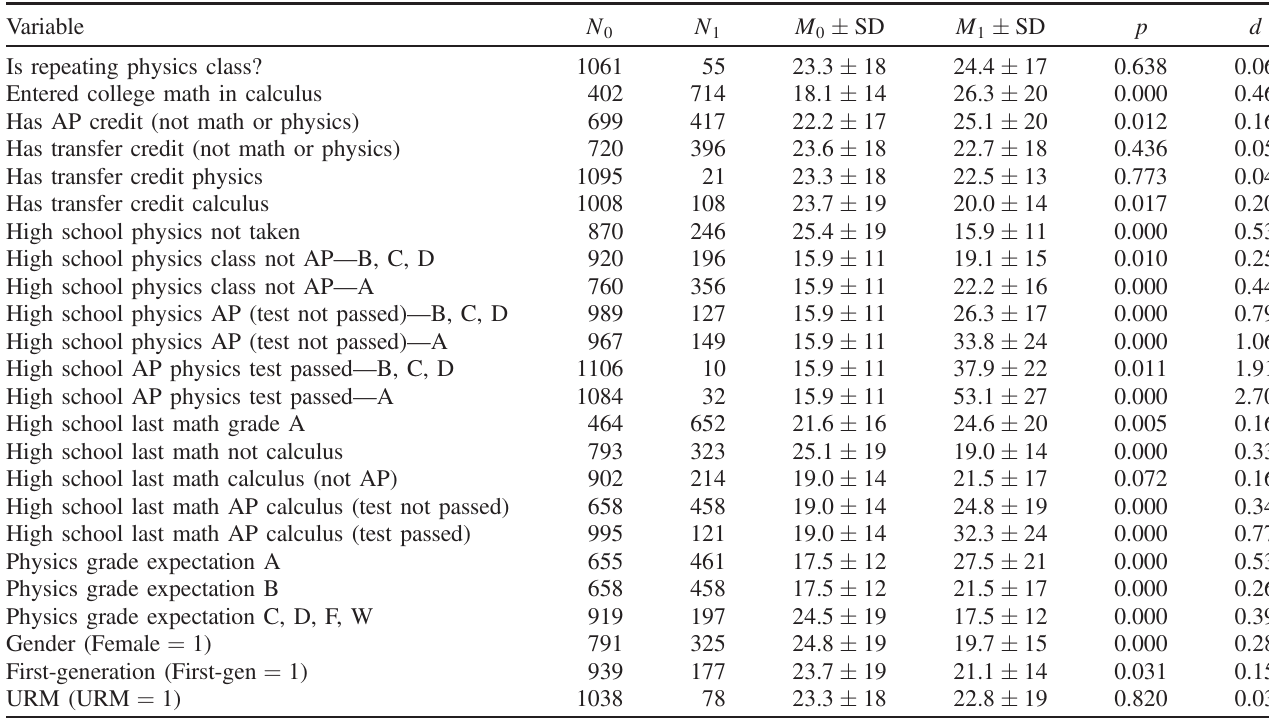
TABLE III. Comparison of dichotomous variables. The levels of the variables are 0 or 1 and are indicated by subscripts. N i represents the number of students in each level. The mean ( M i ) and standard deviation for each level of the variable on the FMCE pretest is also presented. A t test was performed testing the difference between the levels. The significance of the t test is measured by the probability p and the effect size of the difference by Cohen ’ s d